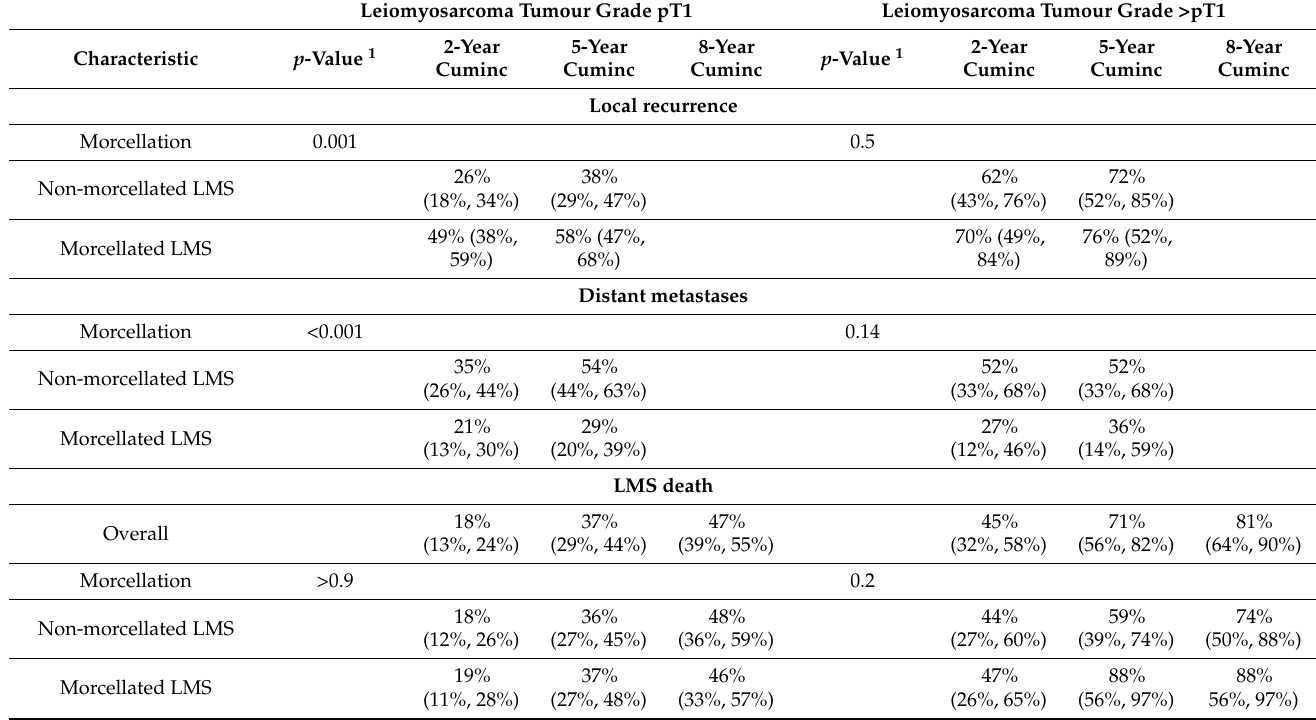
Table 2. Cumulative incidence rates of leiomyosarcoma.